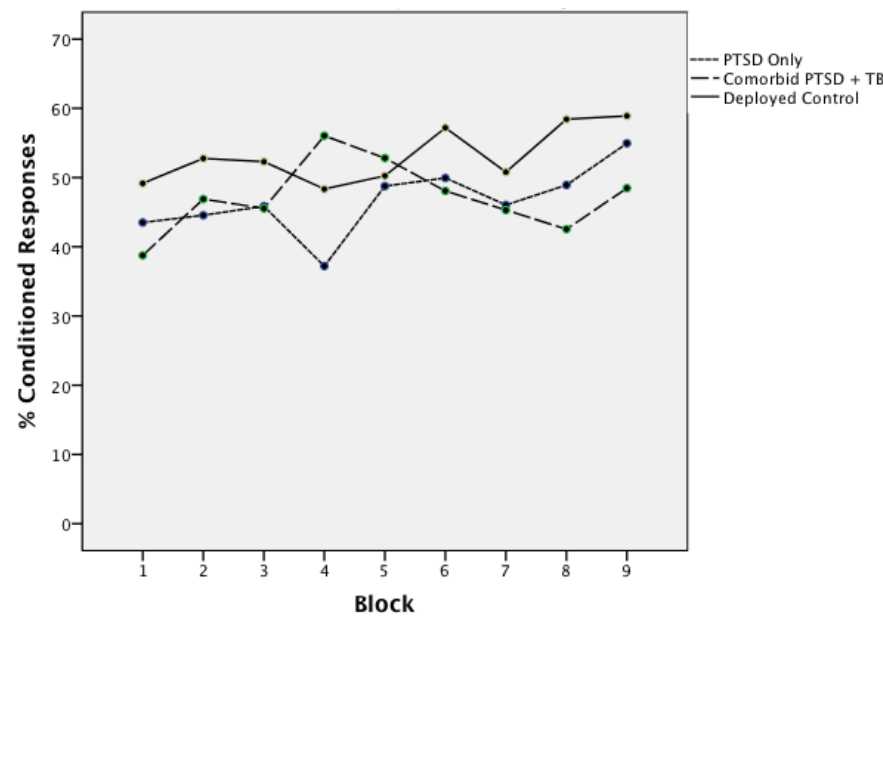
Figure 3. Mean percent conditioned responses by block delay